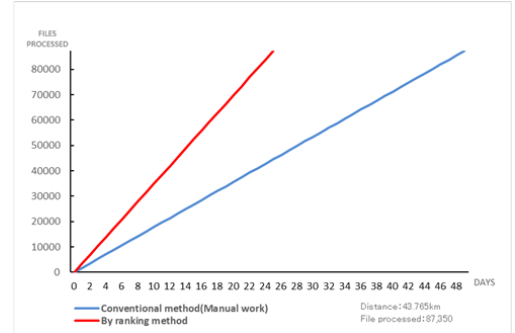
Figure 12. Comparison of workdays between the conventional and ranking